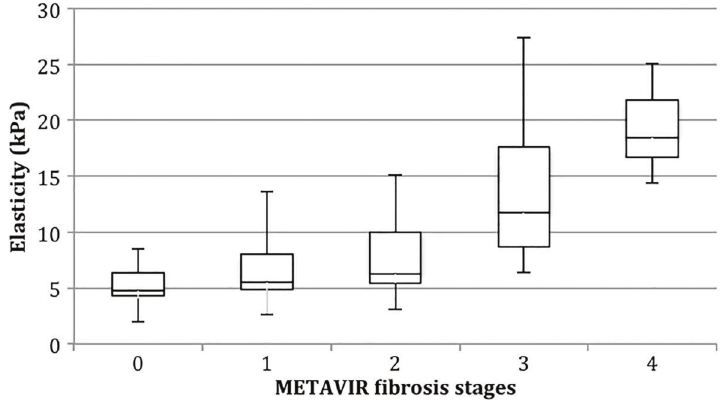
Figure 2. Box plot distribution of Fibroscan results according to METAVIR LB staging. First and third quartiles are represented as top and bottom of the boxes, and the error bars show minimum and maximal values. The vertical length of the box represents the interquartile range and the horizon- tal line through the middle represent the median value.